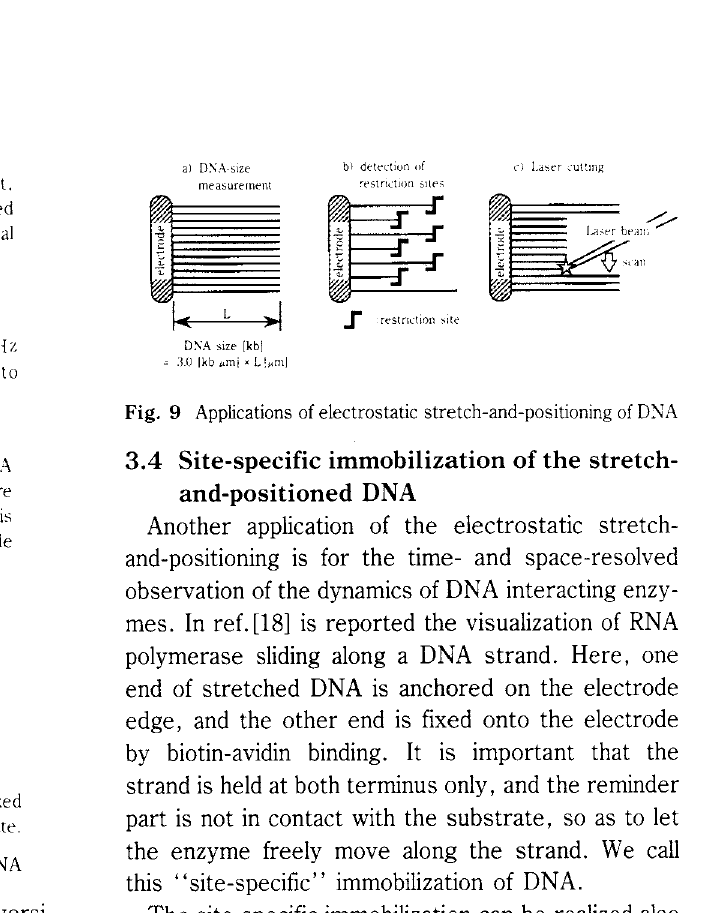
Fig. 9 Applications of electrostatic stretch-and-positioning of